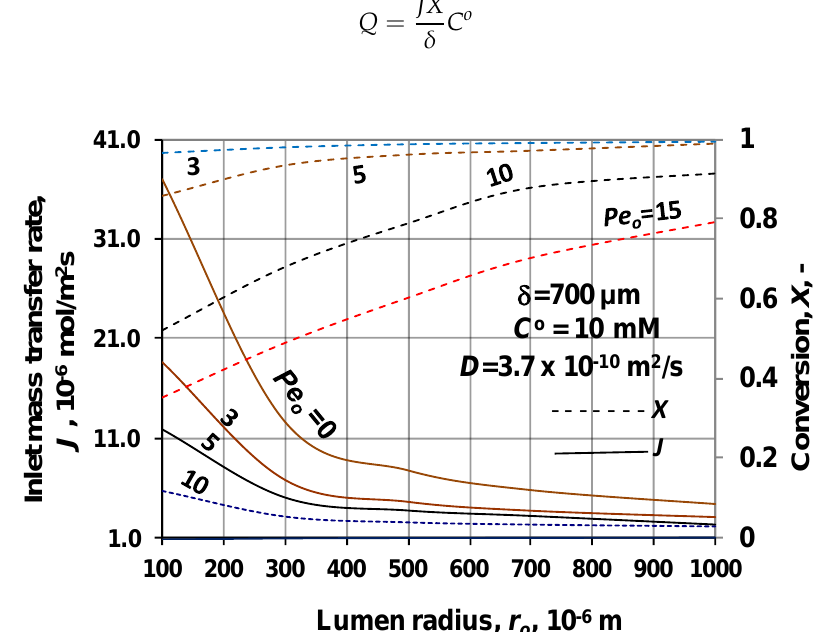
Figure 10. Inlet mass transfer rate and the conversion as a function of the lumen radius, at different values of the membrane Pe o -number. ( D = 3.7 × 10 − 10 m 2 / s; δ = 700 µ m; C O = 10 mM; N = 1000).